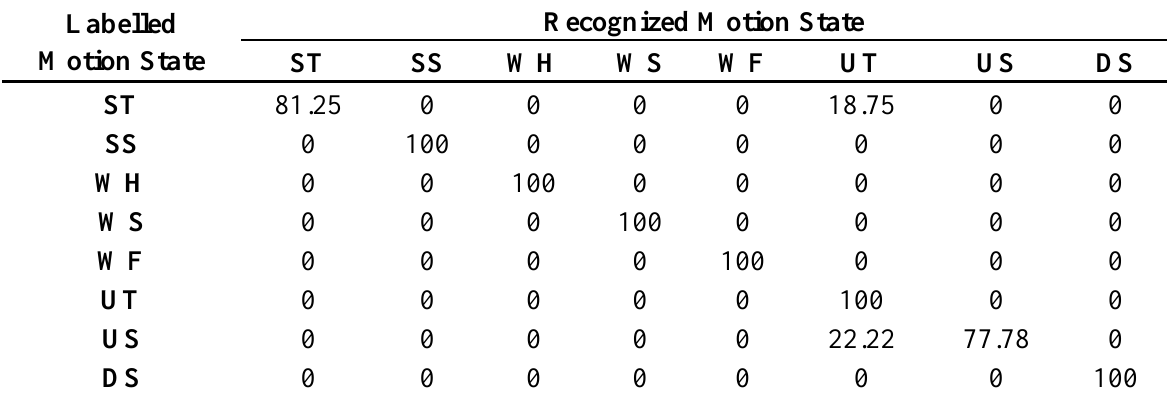
Table 4. Confusion Matrix for the motion recognition from LS-SVM classifier (Unit: %).